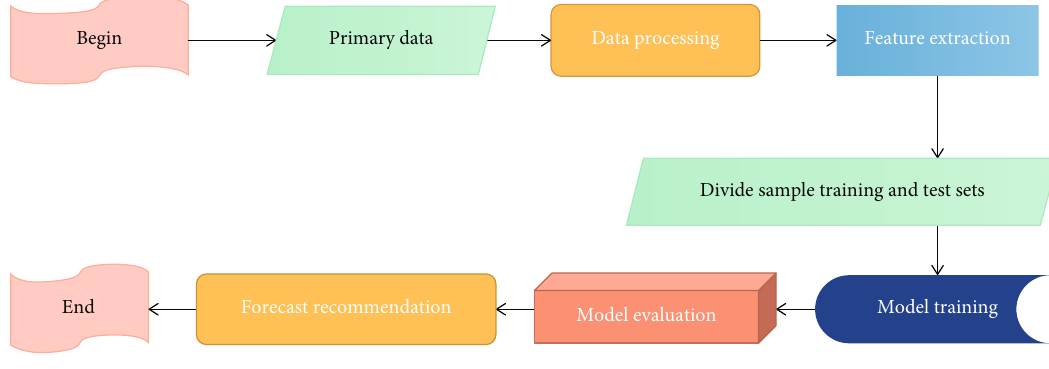
Figure 1: Flow chart of building prediction